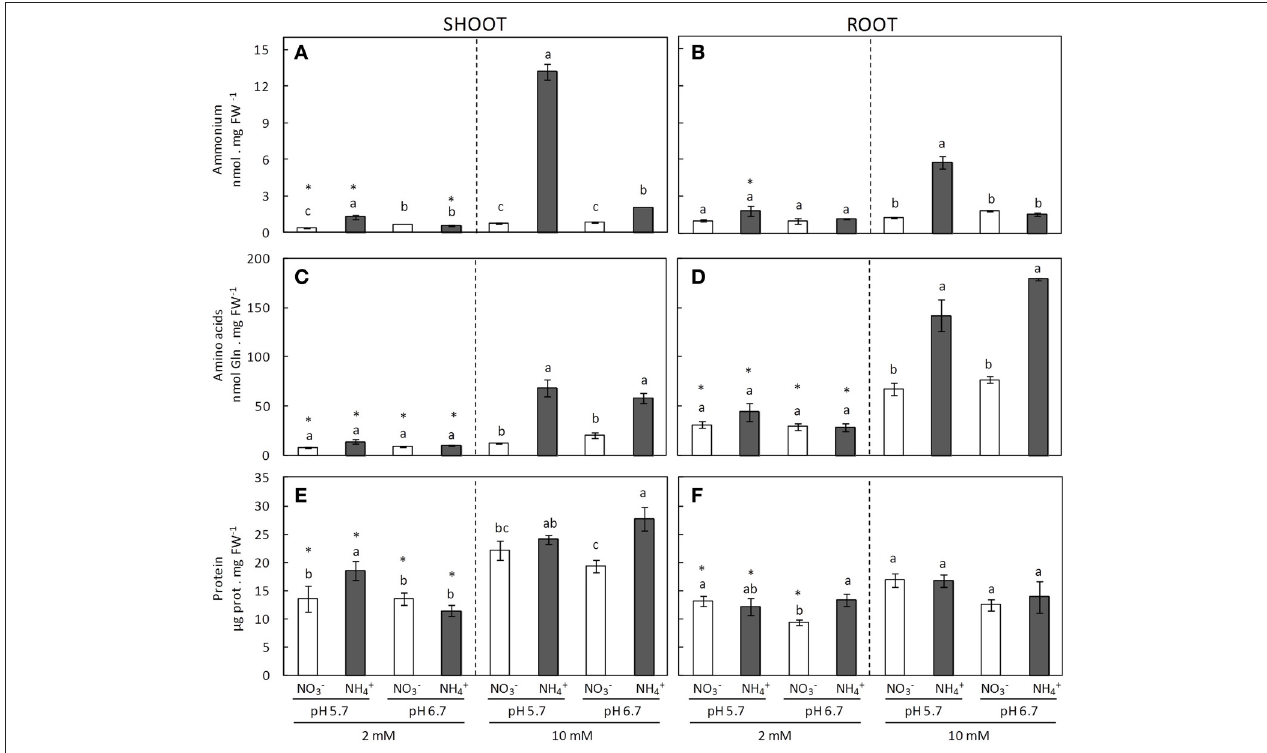
FIGURE 2 | Ammonium (A,B), amino acids (C,D), and protein content (E,F), of shoots (A,C,E) and roots (B,D,F) of plants grown under different conditions of pH (5.7 or 6.7), N source (NO − 3 or NH + 4 ), and concentration (2 or 10mM). Statistical analysis was described in Figure 1 . Columns represent mean ± se ( n = 3 ). Each sample is a pool of three